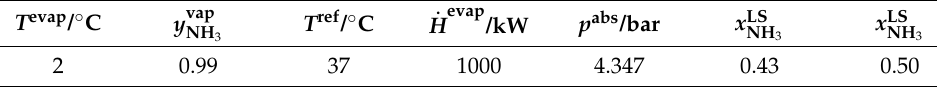
Table 6. Input data for the AC for case study 2.